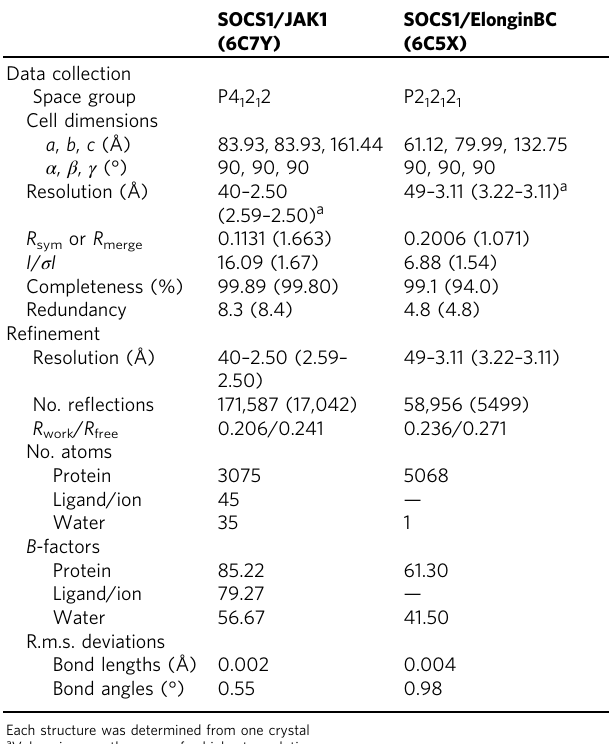
Table 1 Data collection and re fi nement statistics (molecular